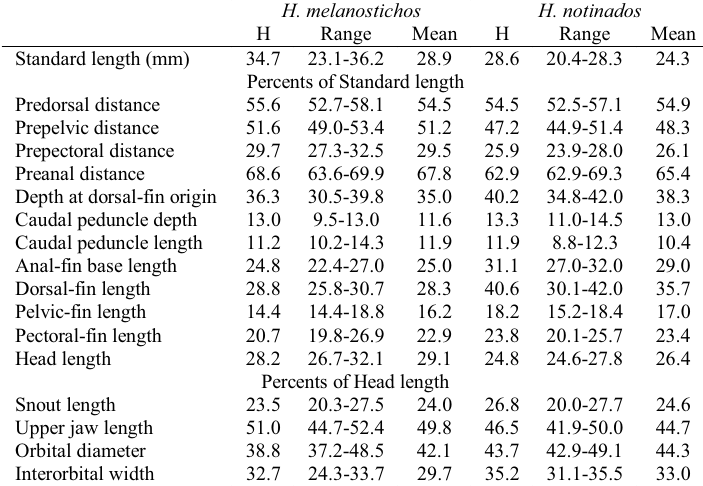
Table 1. Morphometric data of holotype (H) and paratypes of Hyphessobrycon melanostichos (n = 24 including the holotype) and H . notidanos (n = 23 including the holotype) from the upper rio Tapajós